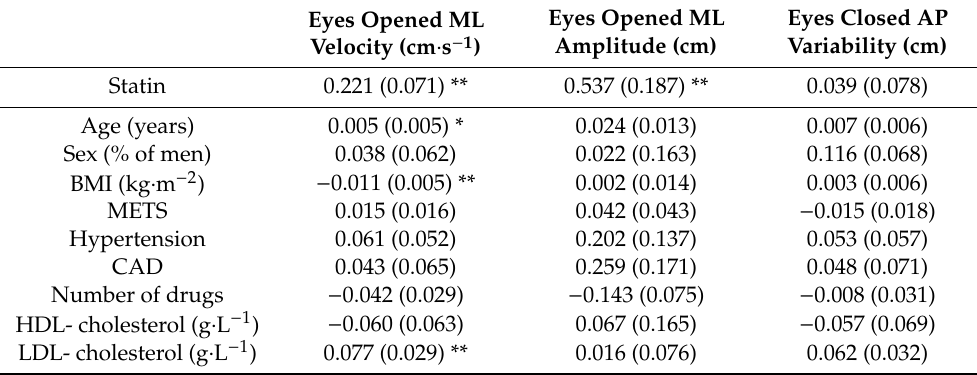
Table 4. Coe ffi cient of the predictors in the significant regression